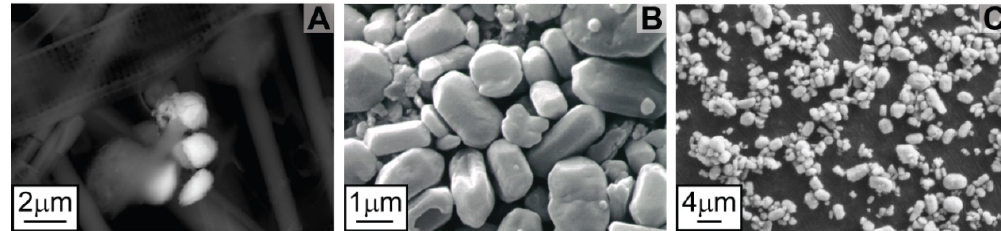
Figure 1. Images of marine barite (BaSO 4 ) using scanning electron microscopy. ( A ) Barite (bright white) in size-fractionated particulate matter collected from the water column in the North Atlantic. ( B ) Barite separated from sediments collected at the sediment-water interface in the Equatorial Pacific. ( C ) Barite separated from a middle Miocene (~13.9 Ma) core sample from International Ocean Discovery Program (IODP) Site U1337 in the eastern equatorial Pacific, located ~315 m below the seafloor.